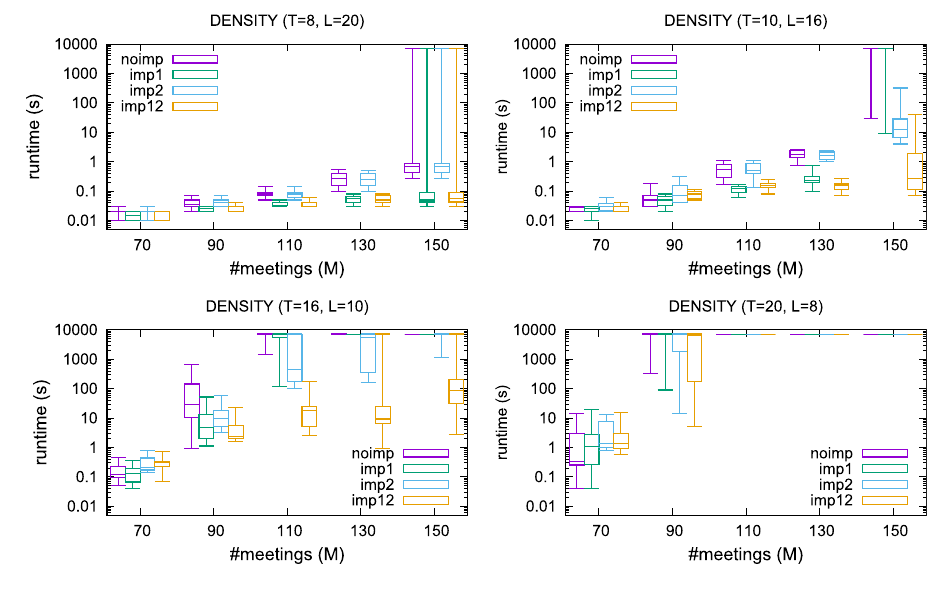
Fig. 1 PAR1 (in seconds) of solving some random B2B families of instances, with and without using implied constraints, vary- ing their density d . Instances are generated using the P = 40 B2Brand model with , M = { 70,90,110,130,150 } , T = 8 L = 20 and (i) and (top T = 10 L = 16 left), (ii) and (top T = 16 L = 10 right), (iii) and T = 20 (bottom left), and (iv) L = 8 and (bottom